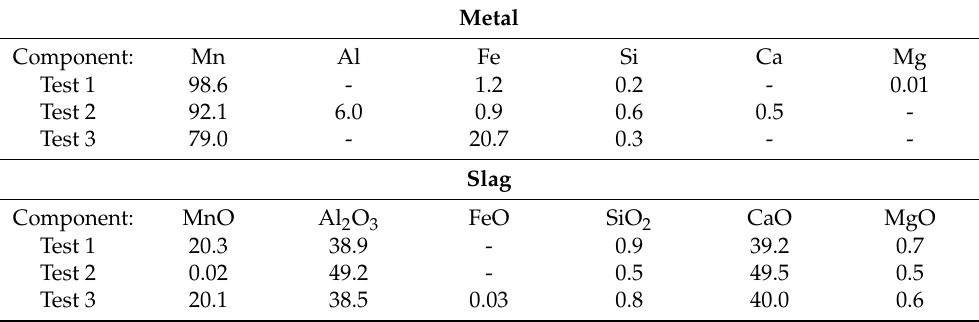
Table 1. The average compositions of metal and slag products in tests 1–3 (in